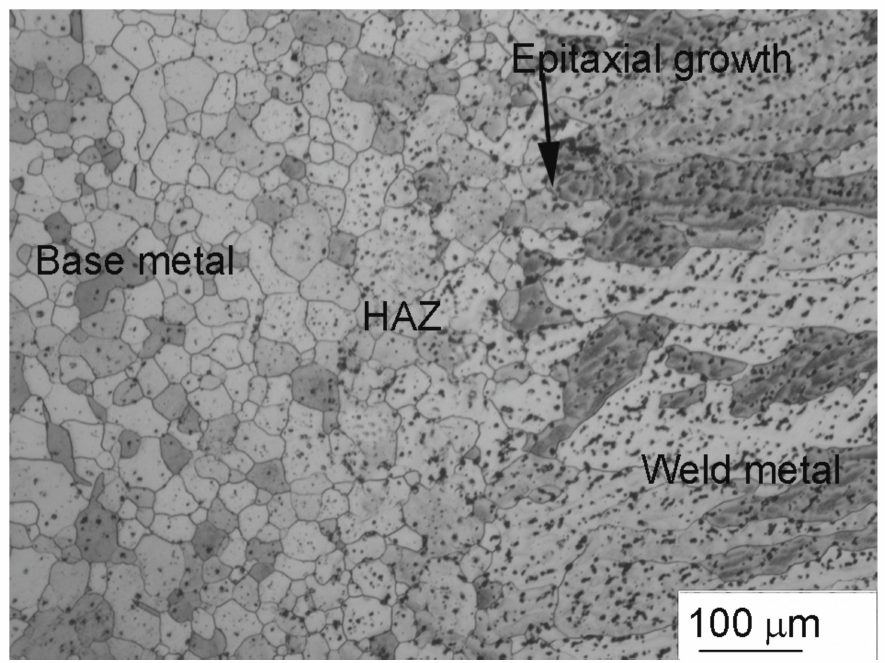
Figure 8. Weld transverse cross-section comparing weld metal, heat-affected zone (HAZ), and base metal micro-structures of AZ31 welded joint prepared with 4 mm/s